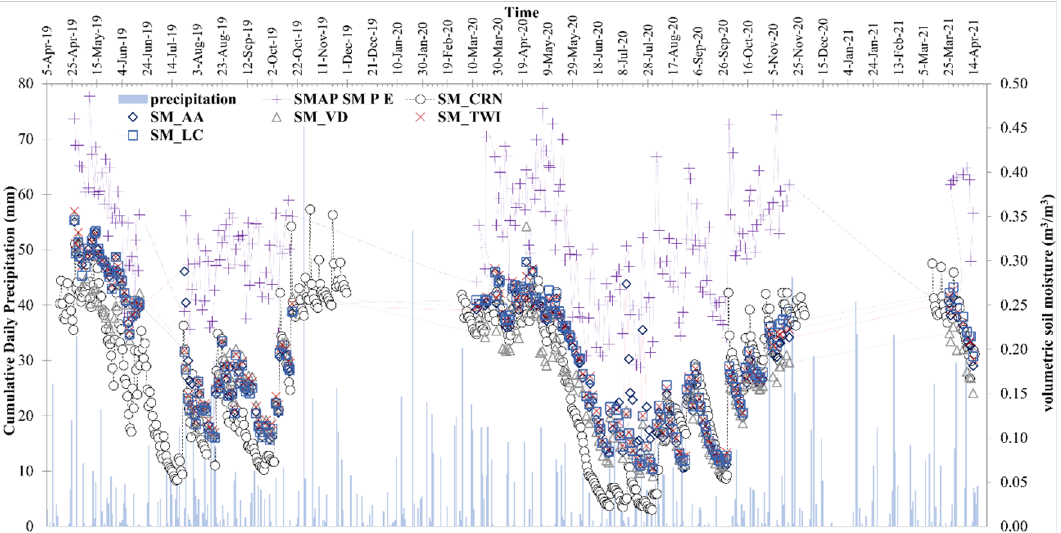
Figure 4. A comparison of the time series of upscaled soil moisture and soil moisture measured by the USCRN permanent station with the soil moisture obtained from the SMAP 33-km pixel. Precipitation records from the USCRN station are also presented. The following time series are